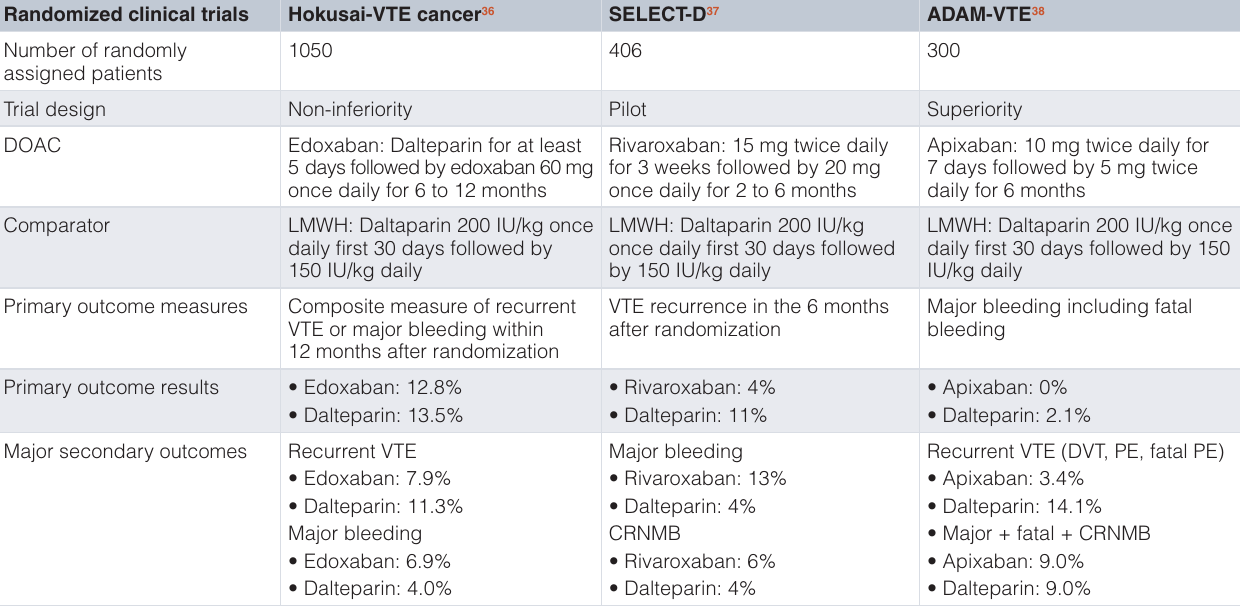
Table 1. Randomized clinical trials assessing the efficacy and safety of direct oral anticoagulants in the treatment of cancer- associated thrombosis. Randomized clinical